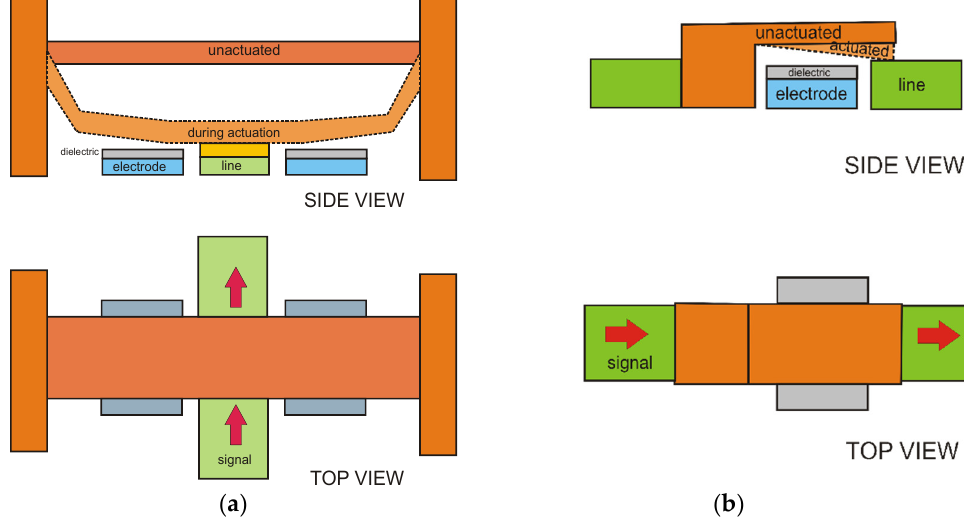
Figure 1. Typical clamped–clamped ( a ) and cantilever ( b ) switch configurations. Both configurations use mobile suspended beams as actuators.